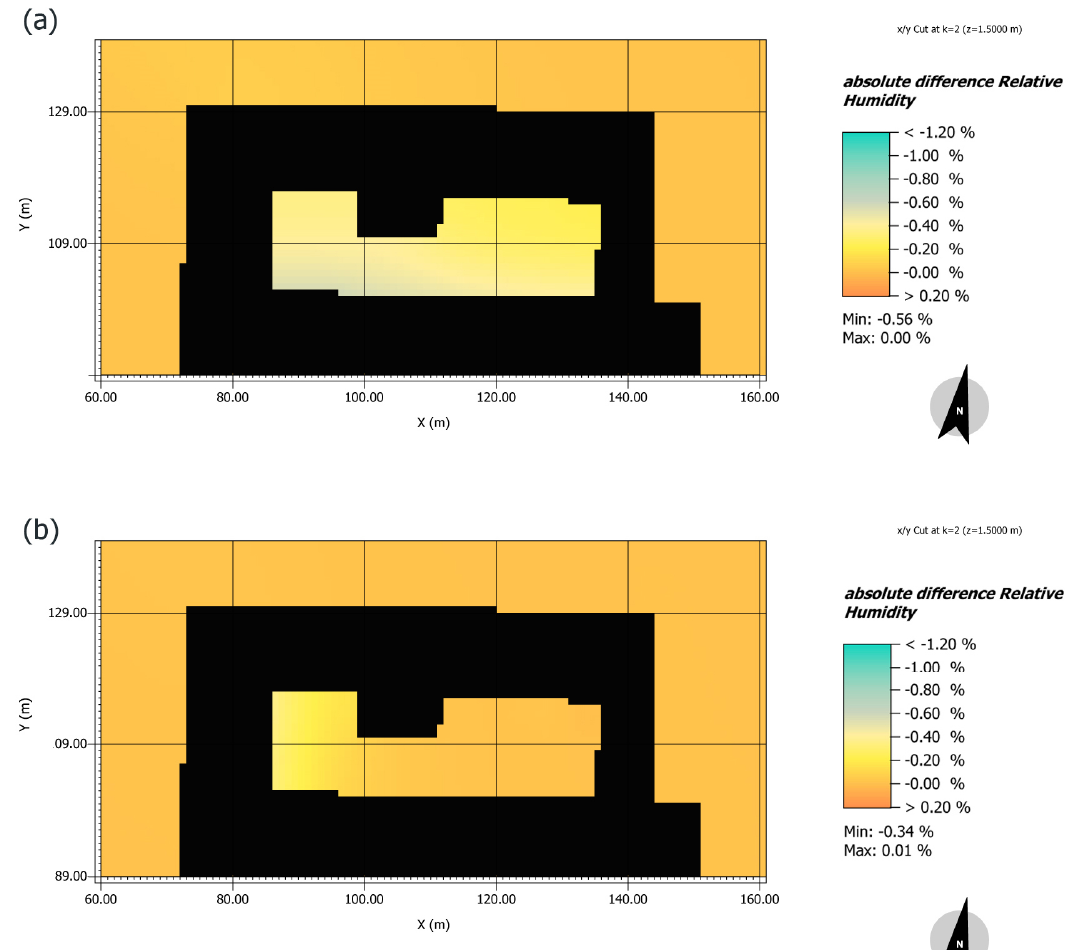
Figure 13. The comparison of initial state with reference green wall relative humidity at the height of 1.5 m in the scenario with greenery placed on the southern ( a ) and western ( b ) wall. Figure by authors. Table 2. Means and medians for different cases of placing green wall in the context of the whole atrium’s interior relative humidity. Numbers with minus signs should be read as an increase from the initial state.